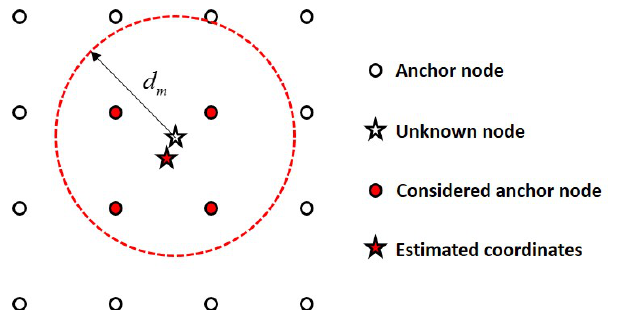
Figure 1. Operation of the conventional weighted centroid localization (C-WCL) algorithm with a distance boundary